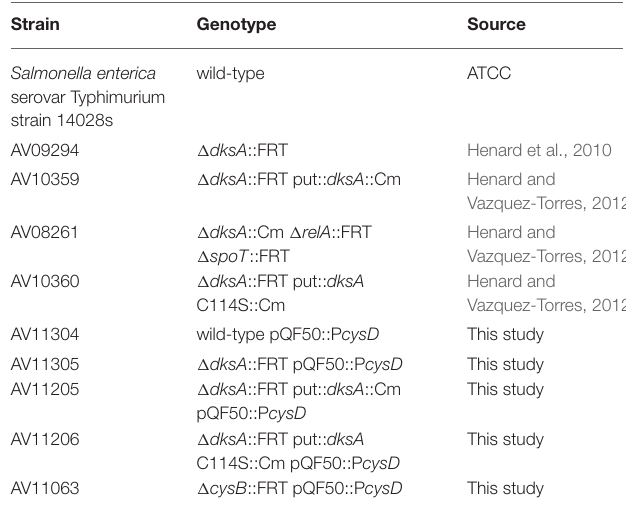
TABLE 1 | Bacterial strains used in this